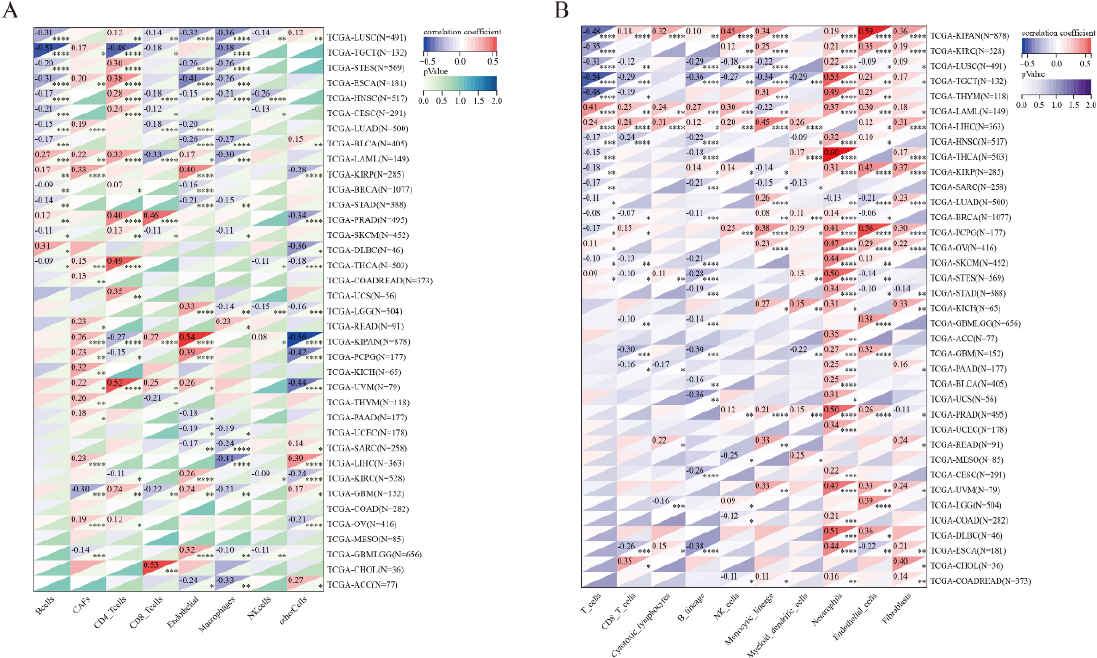
Figure 13. Correlation between SLC2A1 and immune cell infiltration. Heatmap represents correla- tion between SLC2A1 expression and immune cell infiltration using the EPIC ( A ) and MCPcounter ( B ) algorithms (*, p < 0.05; **, p < 0.01; ***, p < 0.001; ****, p <